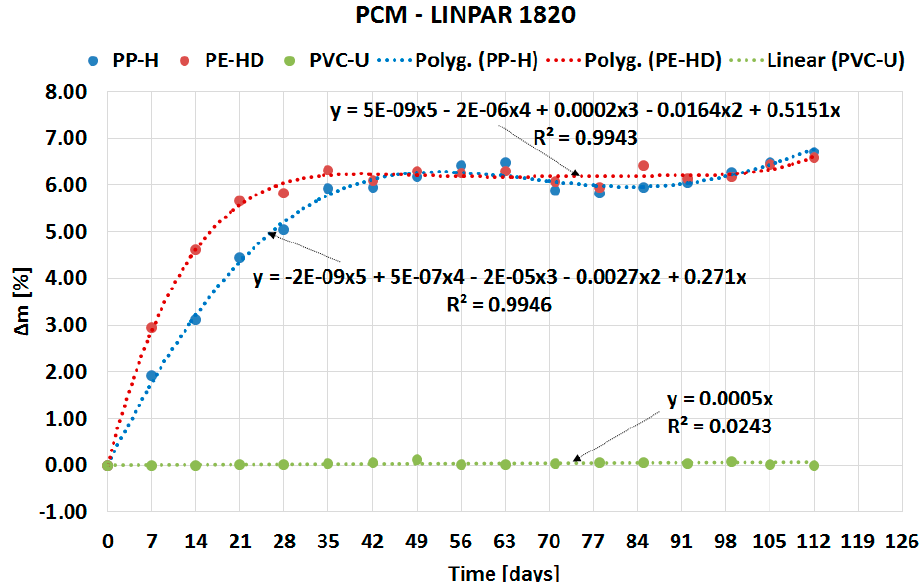
Figure 3. Dependence of mass change of tested plastics on duration of the experiment for Linpar 1820.